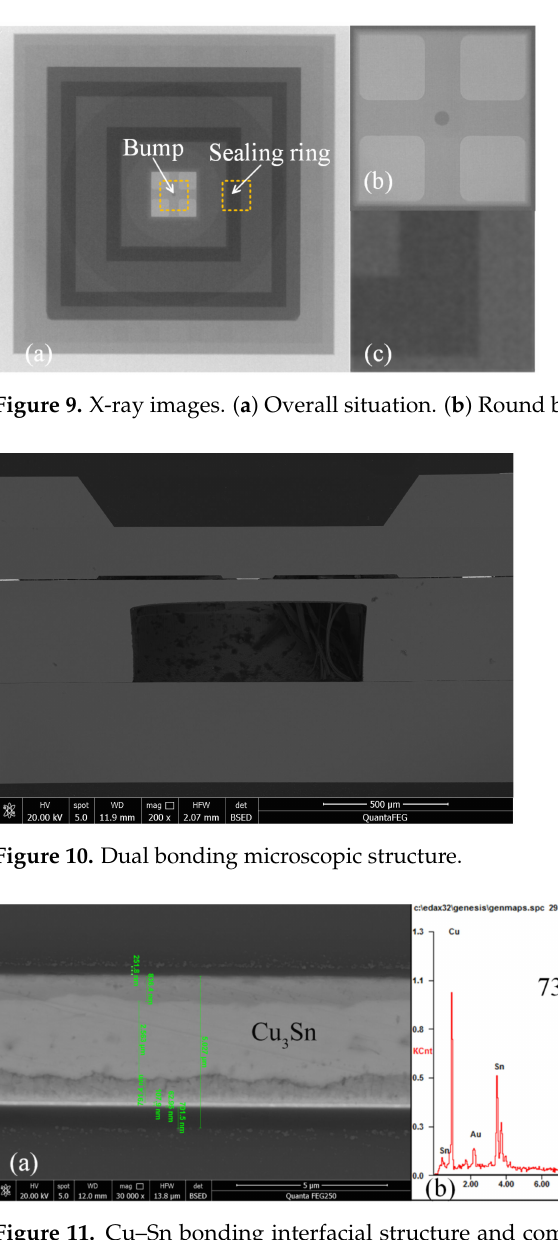
Figure 11. Cu–Sn bonding interfacial structure and composition. ( a ) Cross-sectional SEM image. ( b ) EDS